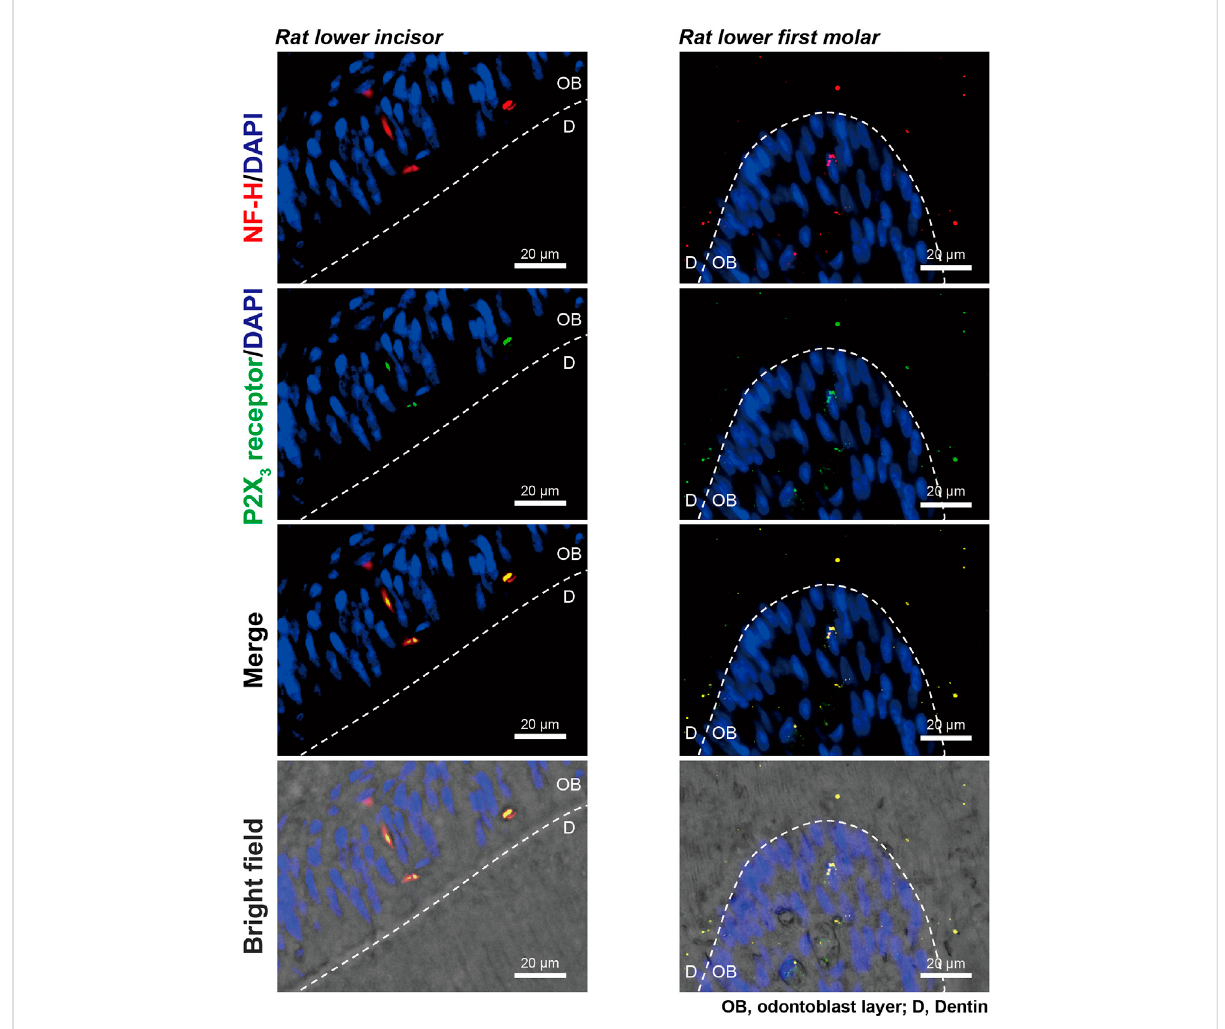
Expression of A-neuron marker protein and P2X 3 receptors at the dentin-pulp border of rat lower incisors and molars. Immuno fl uorescence analysis showed immunoreactivities for myelinated A-neuron marker protein, NF-H (red in upper, second lower, and lower panels), and ionotropic ATP receptor subtype, P2X 3 receptor (green in second upper, second lower, and lower panels), in the dentin-pulp border of rat lower incisors (left panels) and molars (right panels). Nuclei are shown in blue (DAPI). Scale bars, 20 μ